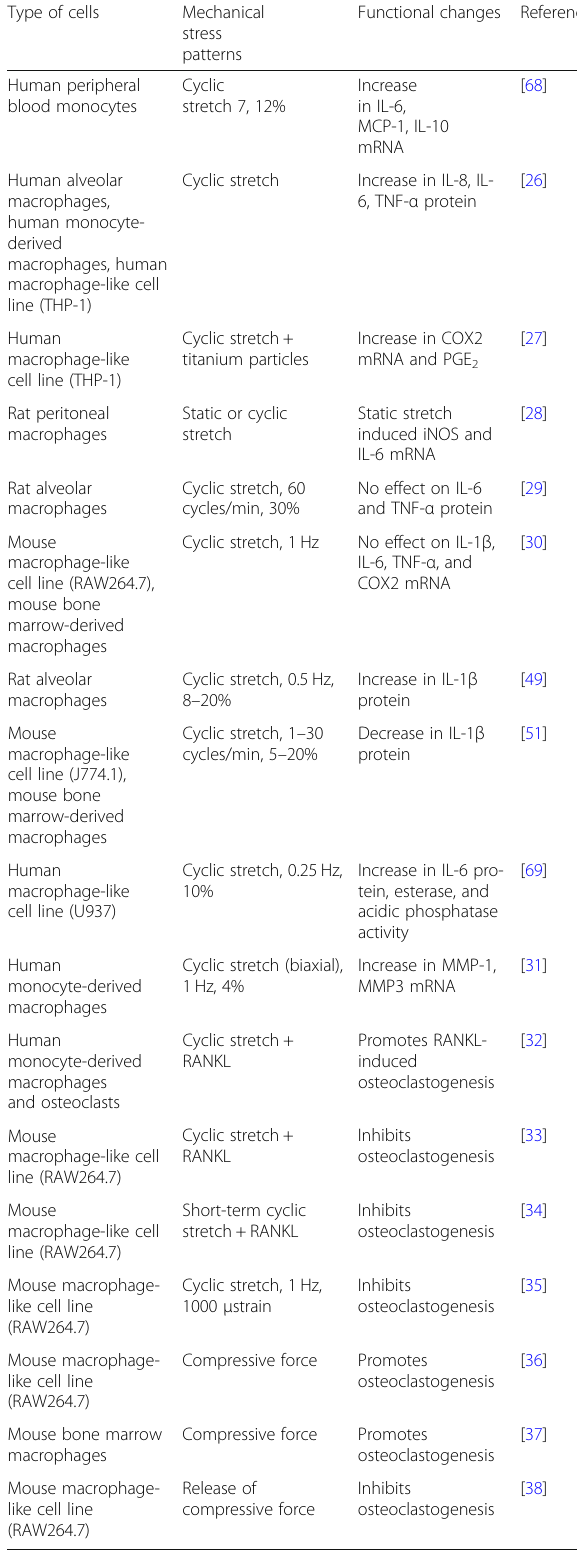
Table 1 The effects of mechanical stress on macrophages Type of cells Mechanical stress